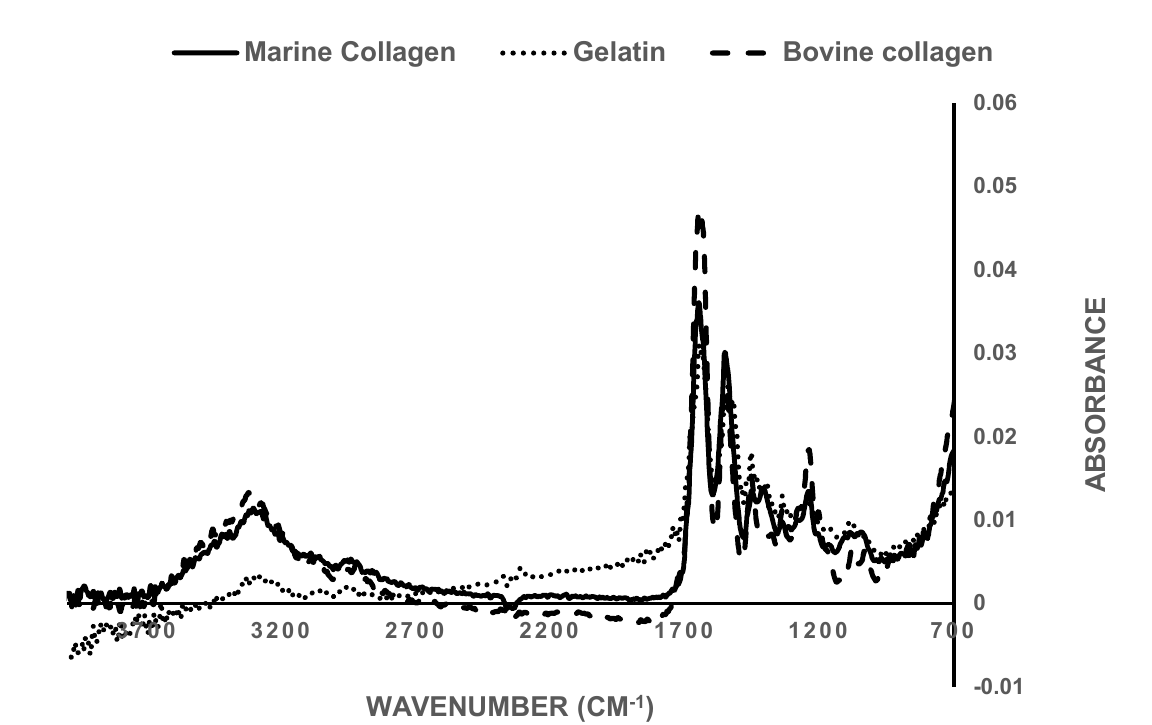
Figure 2. Comparison of FTIR spectra of extracted marine-derived collagen (solid line), commercially available bovine collagen (dashed line) and commercial gelatin (dotted line). Samples were tested as freeze-dried foams at RT.